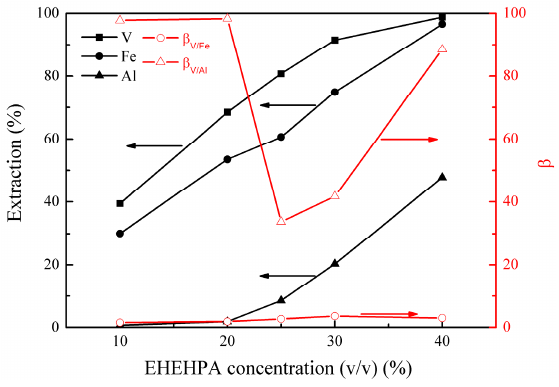
Figure 5. Effect of 2-ethylhexyl phosphoric acid mono-2-ethylhexyl ester (EHEHPA) concentration ( v / v ) on the extraction percentages of V (IV), Fe, and Al, as well as on the separation factors β V/Fe and β V/Al .